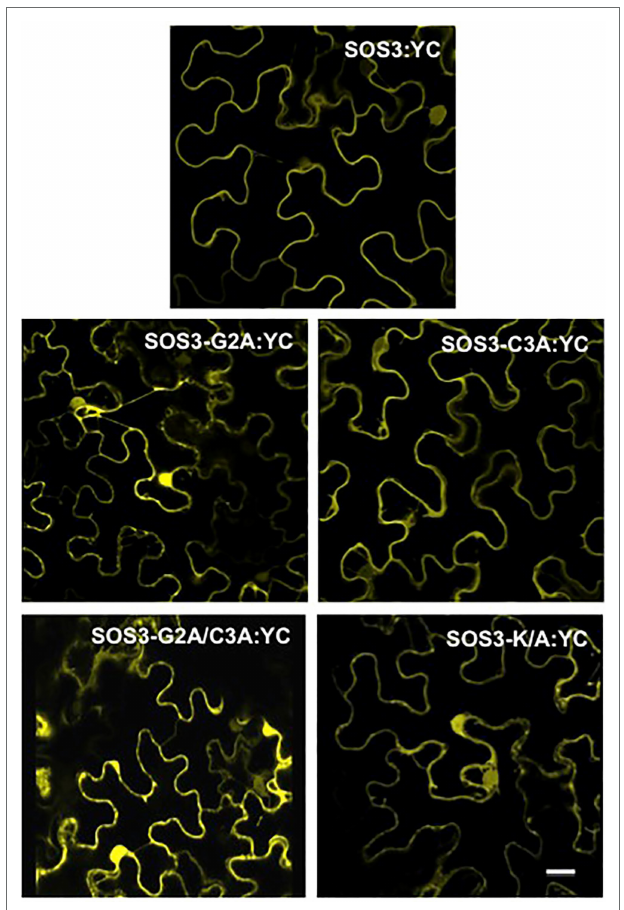
FIGURE 8 | Interaction of SOS2 with SOS3 protein variants by BiFC. Wild-type SOS3 and mutants G2A, C3A, G2A/C3A, and K/A were C-terminally fused with the C-terminal half of YFP (YC) and individually co-expressed in N. benthamiana together with SOS2 N-terminally fused with the N-terminal half of YFP. Reconstituted YFP fluorescence was determined by confocal microscopy 3 days after agroinfection. Co-transformation controls of SOS3-YC and YN-SOS2 with the reciprocal empty vectors produced blank images. Scale bar = 20 μ